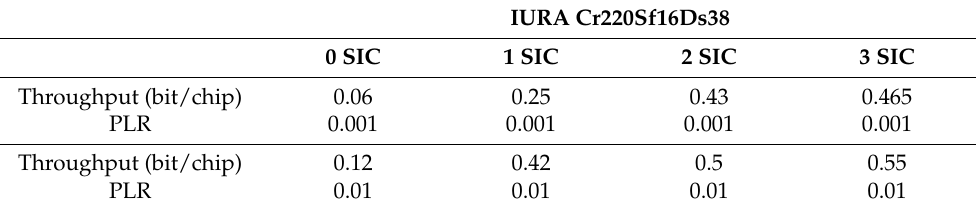
Figure 23. UC#3 IURA PLR performance per SIC iterations. Table 4. UC#3: IURA